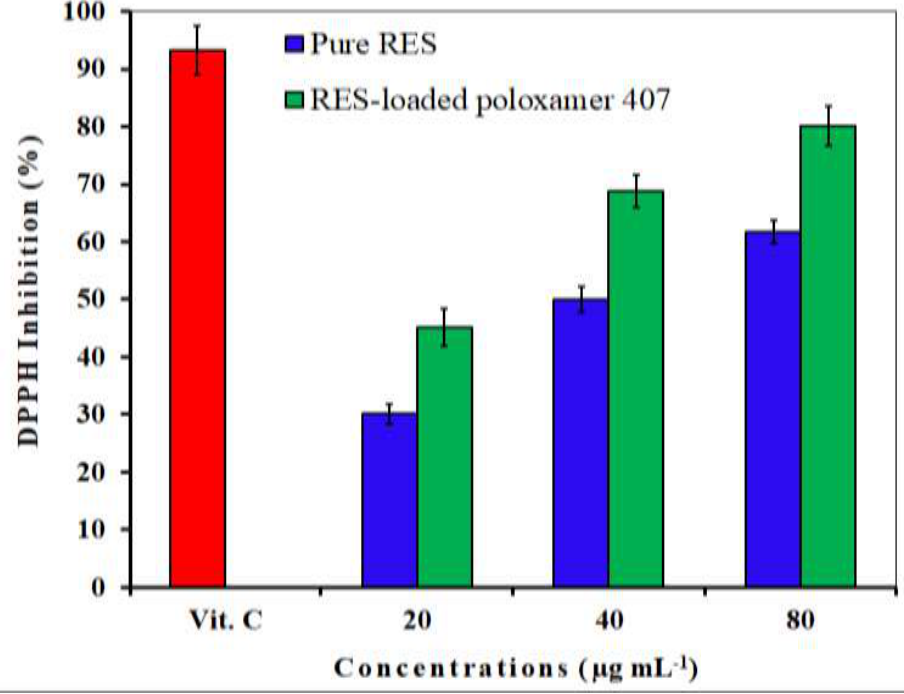
Figure 5: Free radical scavenging activity of pure RES (Blue color) and RES-loaded poloxamer 407 (Green color) using DPPH at three different